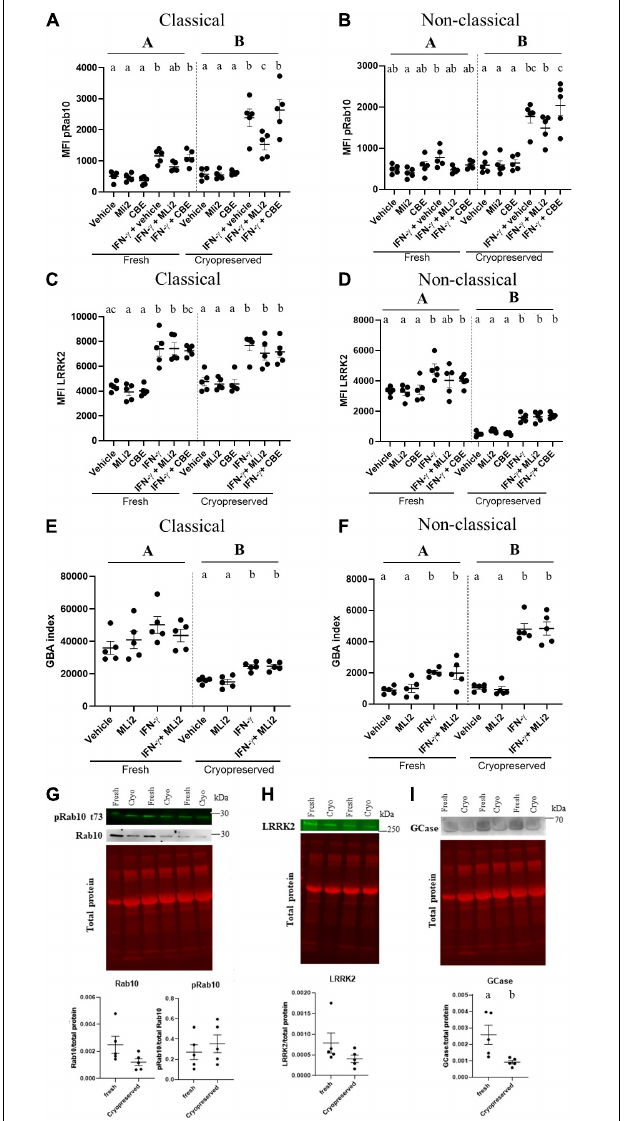
FIGURE 2 | Assessing stimulation-dependent changes in LRRK2 and GCase enzymatic activity overcomes effects of sample cryopreservation. PBMCs from healthy controls were isolated, and either plated after being freshly isolated or cryopreserved for a minimum of 1 week prior to plating ex vivo . Both freshly isolated and cryopreserved cells were plated and stimulated with 100U IFN- γ for 18 h in the presence or absence of 100 nM MLi-2 or 50 µ M CBE. Classical and non-classical monocytes were gated from total PBMCs and assessed for pRab10 (A,B) , LRRK2 (C,D) , and GBA index (E,F) to assess the effect of cryopreservation on these readouts. Bars represent mean ± SEM ( N = 5). One-way ANOVA, Bonferroni post-hoc . Groups sharing the same letters are not significantly different ( p > 0.05) whilst groups displaying the same letter are significantly different ( p < 0.05). Upper-case letters represent main effect of cryopreservation. Lower-case letters represent post-hoc analysis of treatment within groups (fresh or cryopreserved). Both freshly isolated and cryopreserved cells were lysed and assessed for protein expression of pRab10 (G) , LRRK2 (H) , and GCase (I) . Bars represent mean ± SEM ( N = 5). Independent t -test, groups sharing the same letters are not significantly different ( p > 0.05) whilst groups displaying different letters are significantly different ( p <